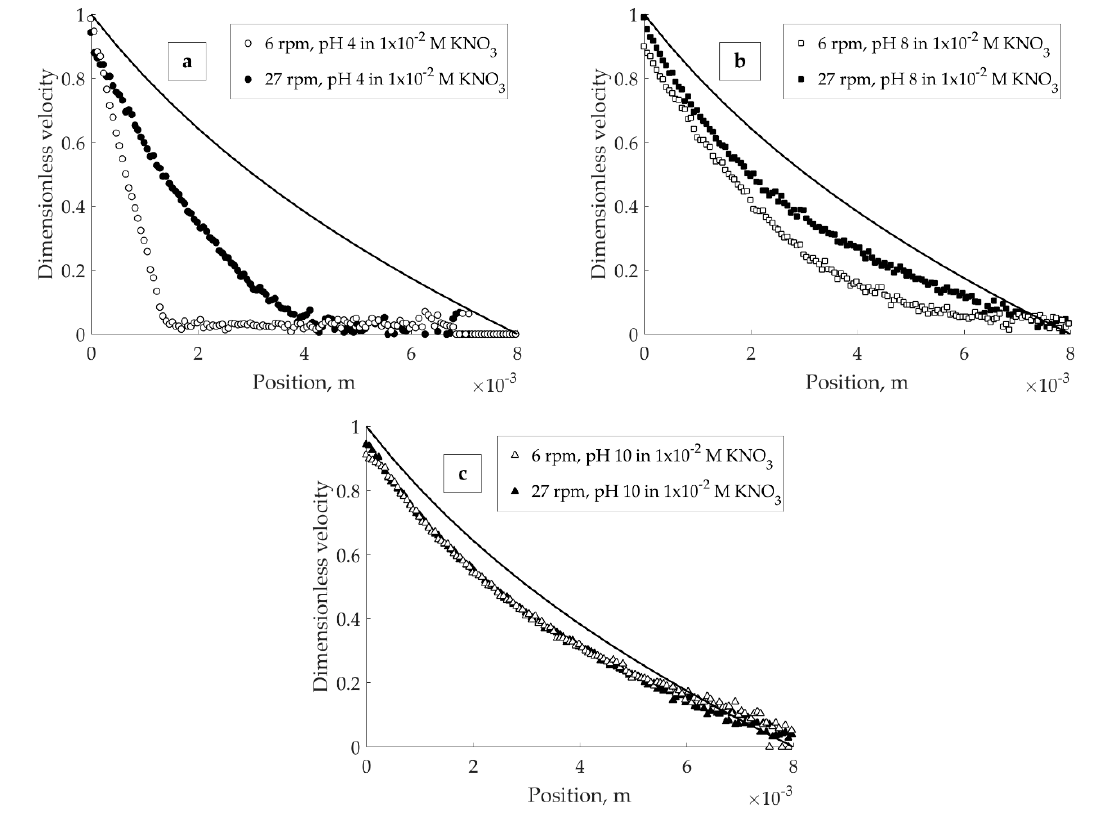
Figure 4. Dimensionless velocity profiles for suspensions at: ( a ) pH 4; ( b ) pH 8; ( c ) pH 10; in 1 × 10 − 2 M KNO 3 , for 6 and 27 rpm rotational velocity.